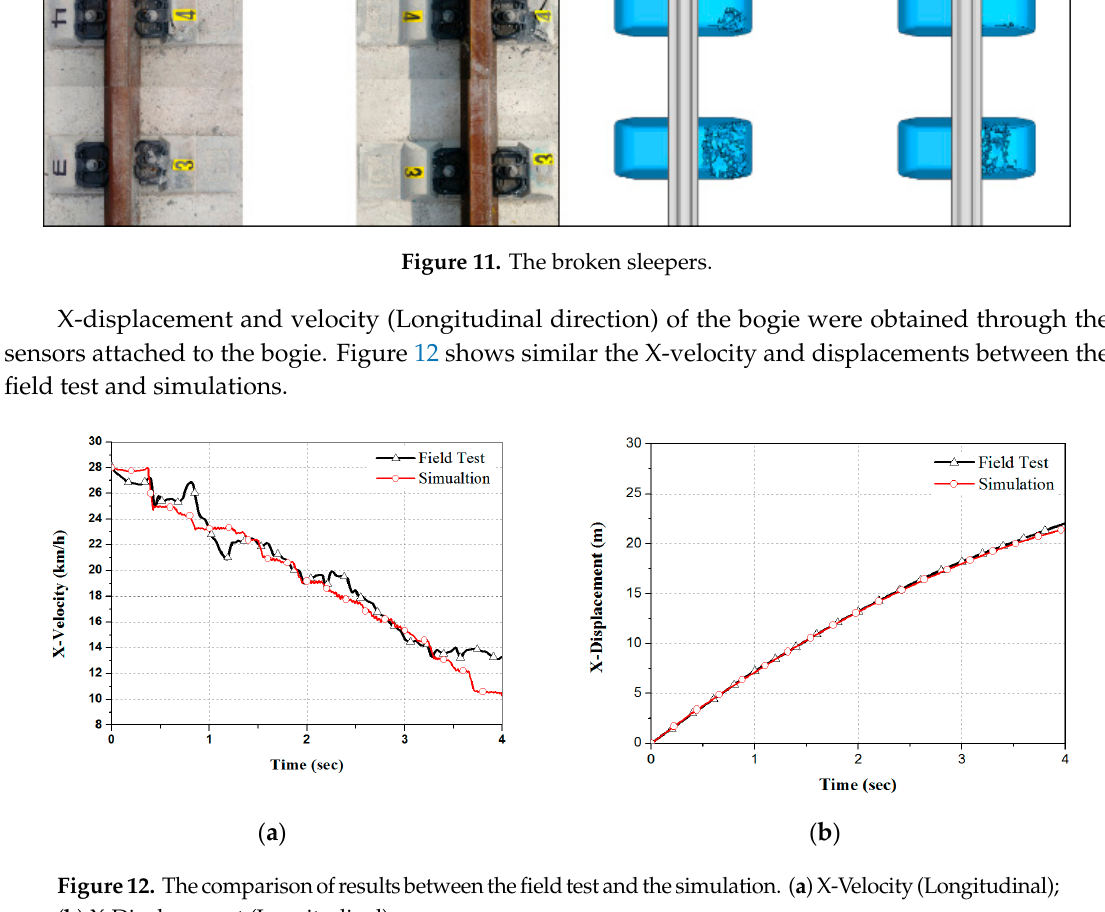
Figure 11. The broken sleepers.